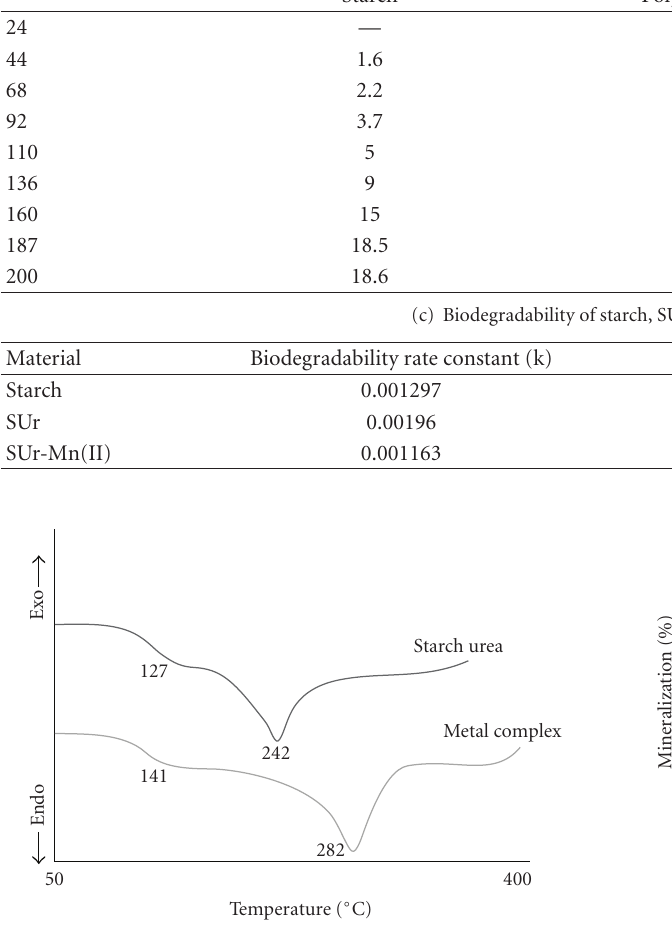
Figure 2: DSC curves of starch urea and its metal complex.